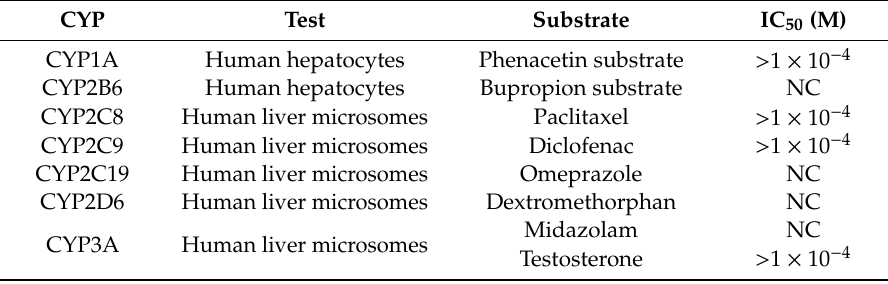
Table 3. Cytochrome P450 (CYP) inhibition.